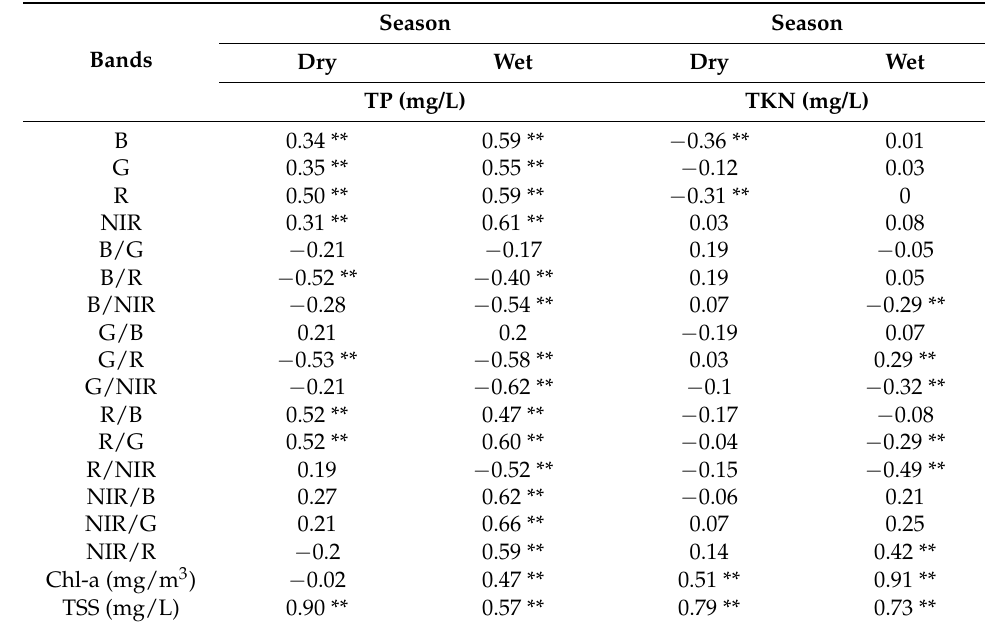
NIR band, and Green/Red band ratio in dry season, and correlated with TSS,